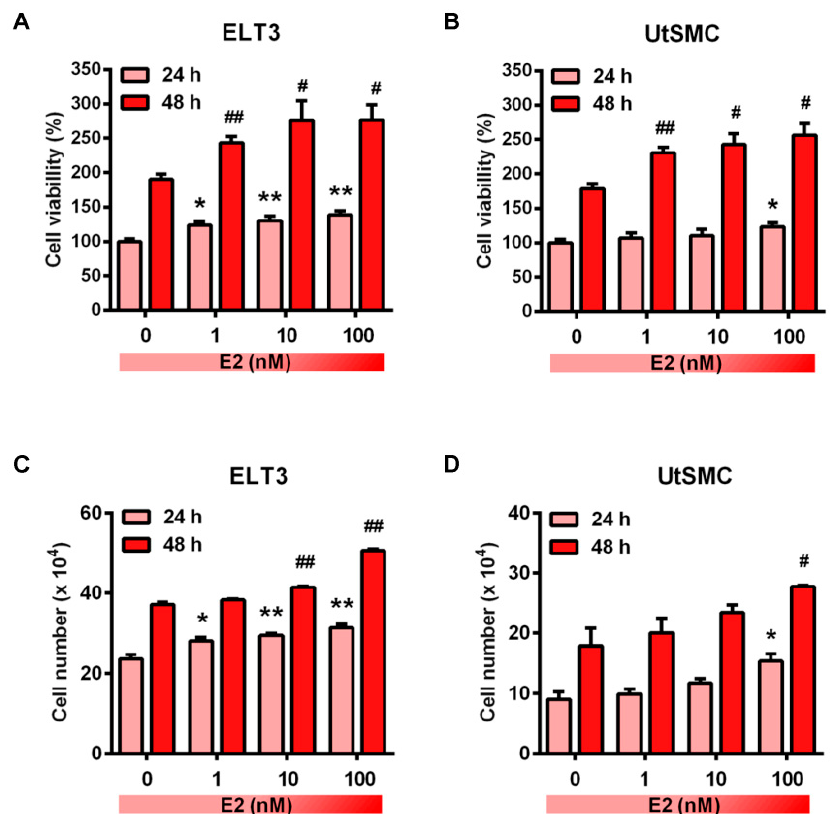
2.2. E ff ects of ISL Treatment on E2-Induced Cell Proliferation in ELT3 and UtSMC Cells Sexual steroid hormones have been reported to promote uterine fibroblast growth [42,43]. Specifically, the over-expression level of aromatase p450 was identified in uterine leiomyoma that catalyzes androgens to estrogens in situ and has a critical role in the promotion of leiomyoma growth [44,45]. Therefore, we first identified whether treatment of ELT and UtSMC cells with E2 promoted cell growth. The results showed that the cell proliferation rate of ELT3 and UtSMC cells increased after treatment of cells with E2 at concentrations from 1 to 100 nM for 24 and 48 h (Figure 2A,B). The cell numbers results aligned with those from the MTT assay in both ELT3 and UtSMC cells (Figure 2C,D). Therefore, we further examined whether ISL could inhibit E2-induced ELT3 and UtSMC cell proliferation. The MTT assay results showed that E2-induced cell proliferation was inhibited by co-treatment with ISL in both ELT3 and UtSMC cells (Figure 3A,B). The results of the crystal violet assay and the cell number assay were consistent with MTT assay in both ELT3 and UtSMC cells (Figure 3C–F).